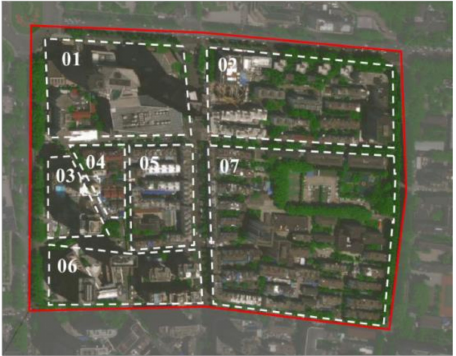
Figure 1. Research block